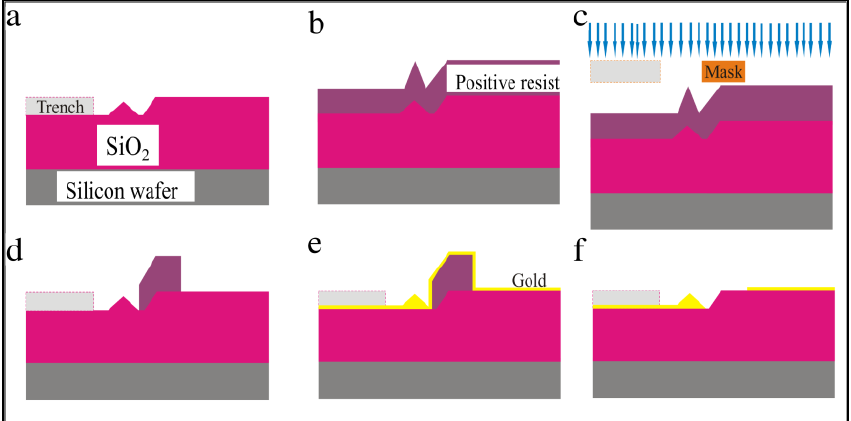
Figure 7. Schematic illustration of Mask 2 processes. ( a ) Wafer after Mask 1 showing the trench- well-tip features throughout. ( b ) Resist layer spin-coated and baked for 5 min. ( c ) Mask 2 is applied during lithographic exposure. ( d ) Patterned device after developing. ( e ) Deposition of 100 nm of gold. ( f ) Final metallized wafer after liftoff.